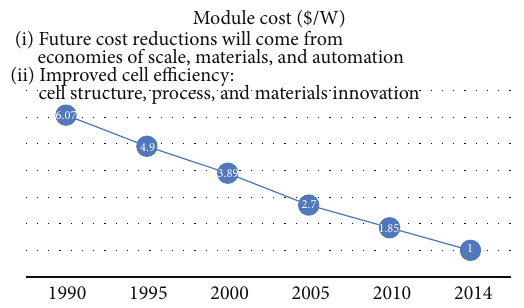
Figure 5: Photovoltaic industry learning curve cost per watt [14].